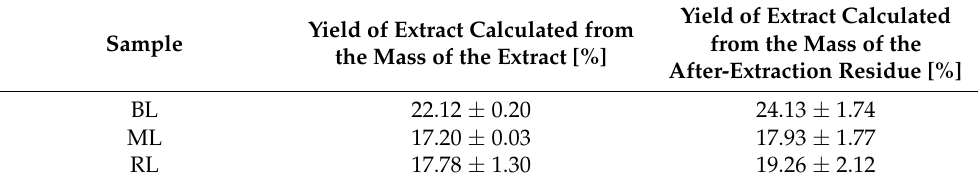
Yield of material soluble in mixture of chloroform and methanol and yield of residual material. Yield of Extract Calculated from Sample the Mass of the Extract [%]